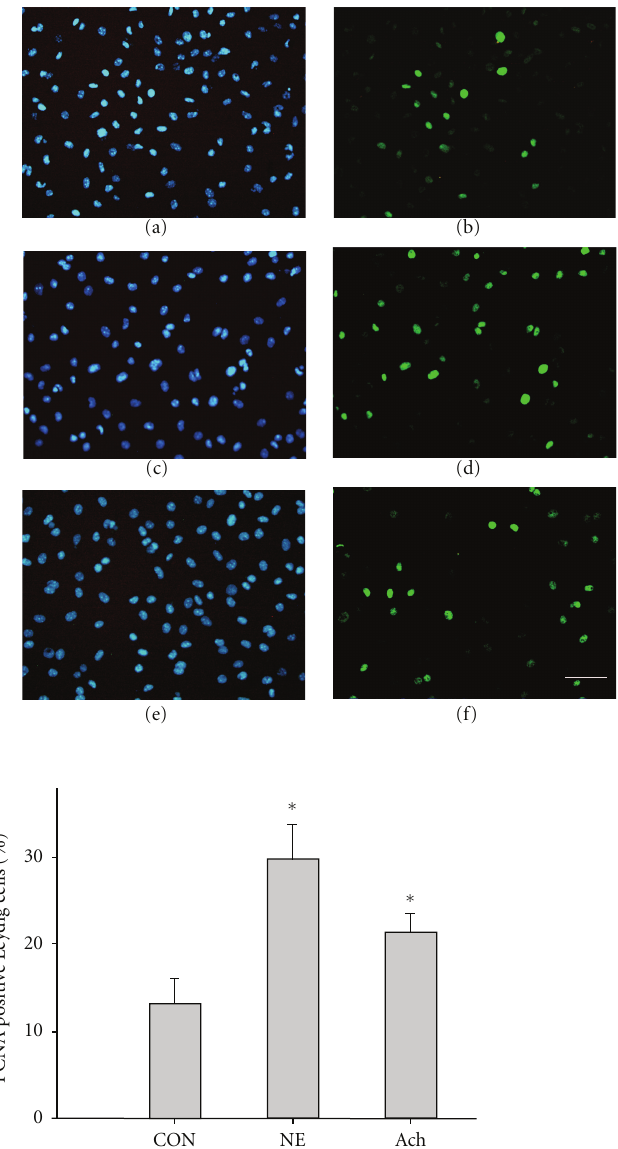
Figure 4: Immunofluorescence staining of PCNA in the Leydig cells cultured with NE and Ach on PD15. The percentage of PCNA-positive (green) cells to total Leydig cells (blue) was presented as means ± SEM. A single asterisks ( ∗ ) indicates statistical significance ( P < 0 . 05) relative to the untreated control. (a) and (b) control group cultured with the same dilution of NE and Ach. (c) and (d) NE group cultured in the presence of 10 μ M NE. (e) and (f) Ach group cultured in the presence of 10 μ M Ach. (b, d and f) Originated from the same photo (a), (c) and (e) with FITC staining only. Nuclei (blue) of all Leydig cells were stained with Hoechst 33258. Bar = 50 μ